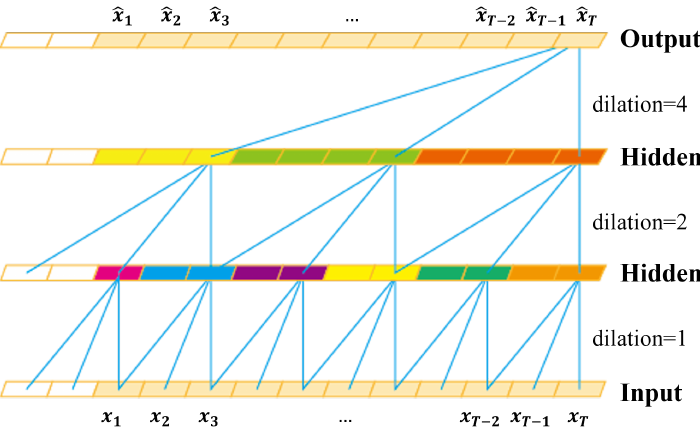
Figure 2. Convolution by the LFP-TCN: The convolution is performed with the kernel size of 3 and dilation rate of ( 1,2,4 ) . The colored elements in hidden layers illustrate max-pooled elements. The kernel size of the max-pooling is the same as the dilation rate on each layer. This operation compresses local information of neighboring non-filtered